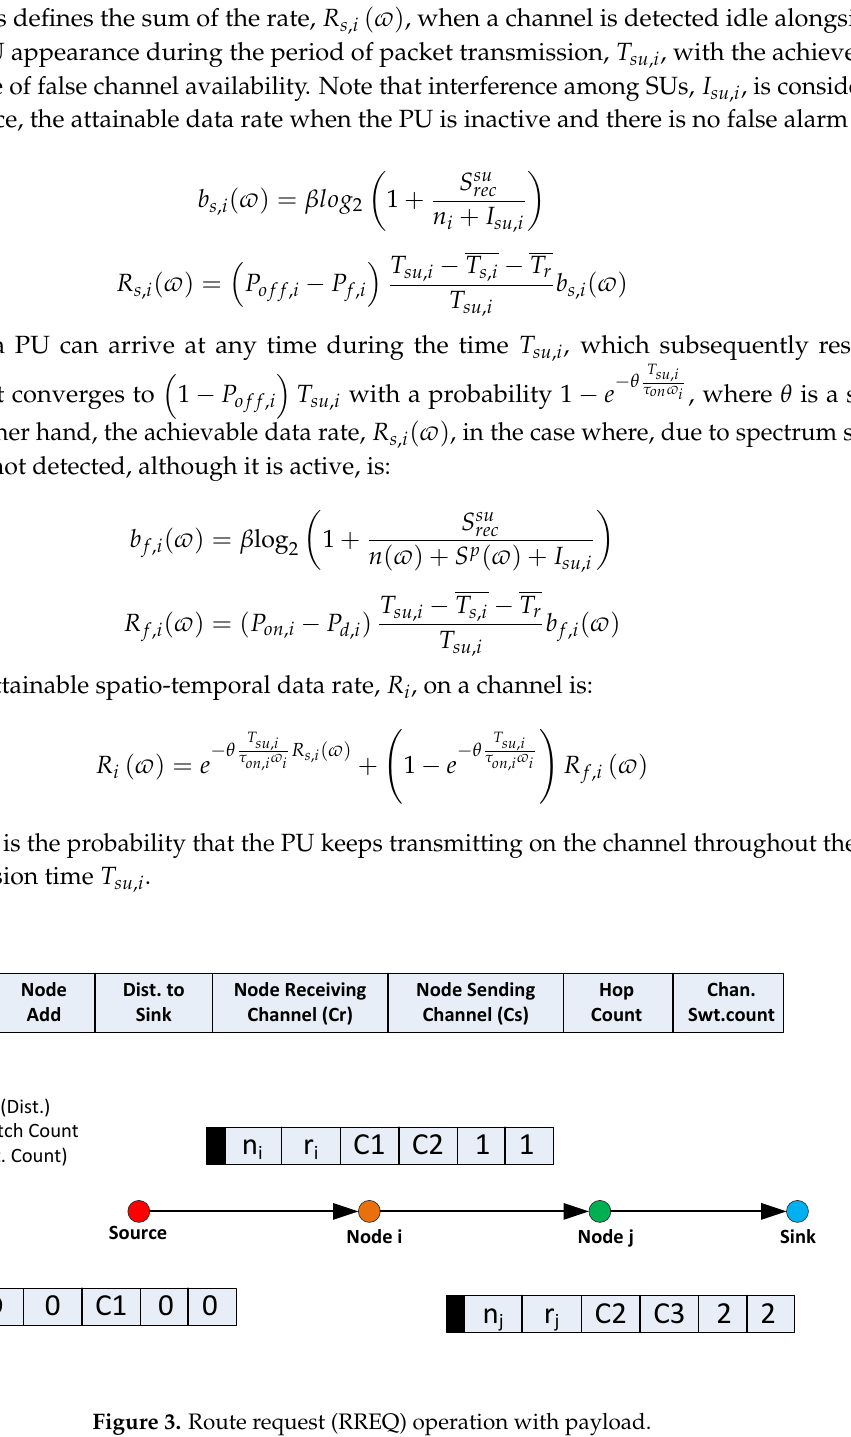
Figure 3. Route request (RREQ) operation with